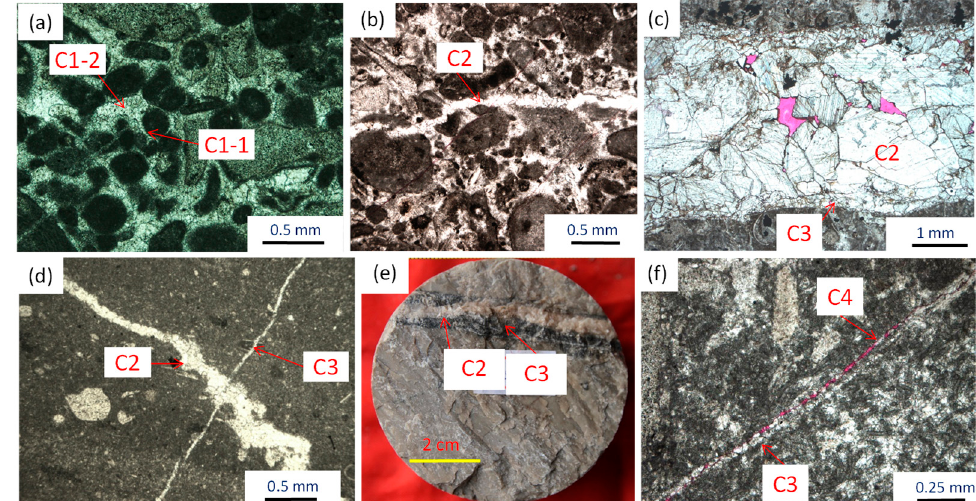
Figure 6. Photographs and photomicrographs illustrating cementation and dissolution textures observed in core ( e ) and thin section samples ( a – d , f ) of the Ordovician carbonates in the Halahatang area (pink-dye resin impregnated to better show fracture porosity). ( a ) Fine cements (C1-1) with isopachous coating the grains, coarse granular cements (C1-2) within the intergranular porosity in the country rocks, X101, 6822.08 m; ( b ) the late fracture filled cements (C2) cut across and overprinted the early intergranular cements (C1), H7-1, 6579.58 m; ( c ) two stages of cementation filling in a micro-fault, with earlier wide cements (C2) in the center separated the narrow fine cements on the wall (C3), H803, 6598.85 m; ( d ) a narrower cement vein (C3) terminated on a wider vein (C2), H11-1, 6683 m; ( e ) a white cement (C2) occurring in the fracture center divides the bitumen impregnated cements (C3) to highlight two stages of cementation, H801, 6733.6 m; ( f ) late partially filled cements (C4) in the fracture cuts across and merged with the earlier fully cemented (C3) fracture, H7-1, 6581.22 m.